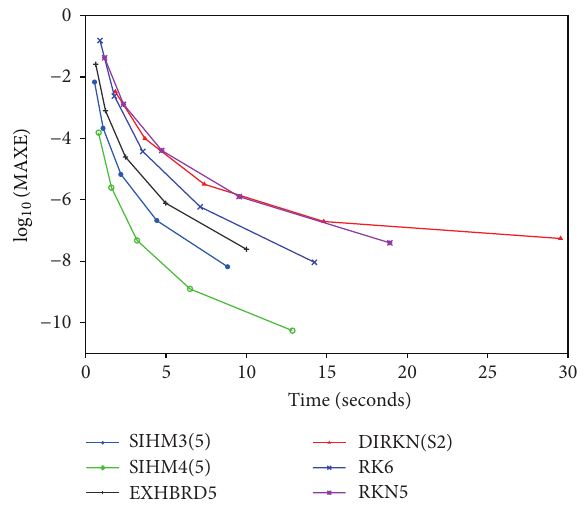
Figure 13: The efficiency curves for SIHM3 (5) and SIHM4 (5) methods for Inhomogeneous system with ℎ = 0.9/2 𝑖 , 𝑖 = 1,...,5 .